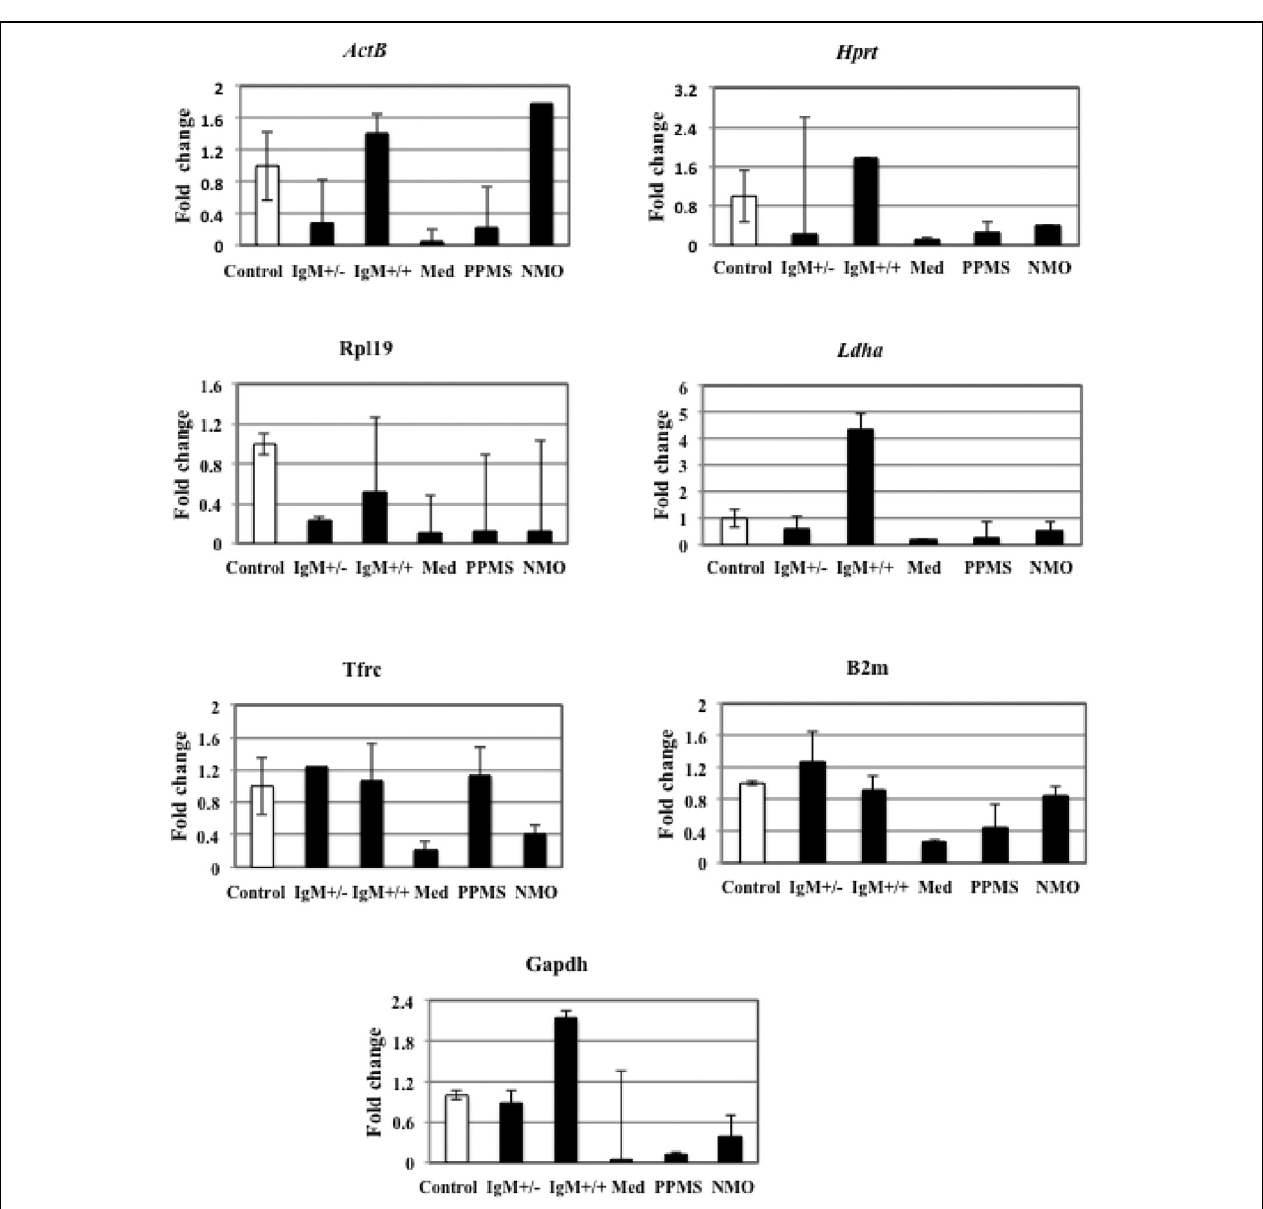
FIGURE 3 | Fold change for each reference gene tested in distinct disease courses of multiple sclerosis (MS). IgM + / + and IgM + / − : Inflammatory forms of relapsing remitting MS; Med: medullary form; NMO: neuromyelitis optica; Control: other non-inflammatory neurological diseases